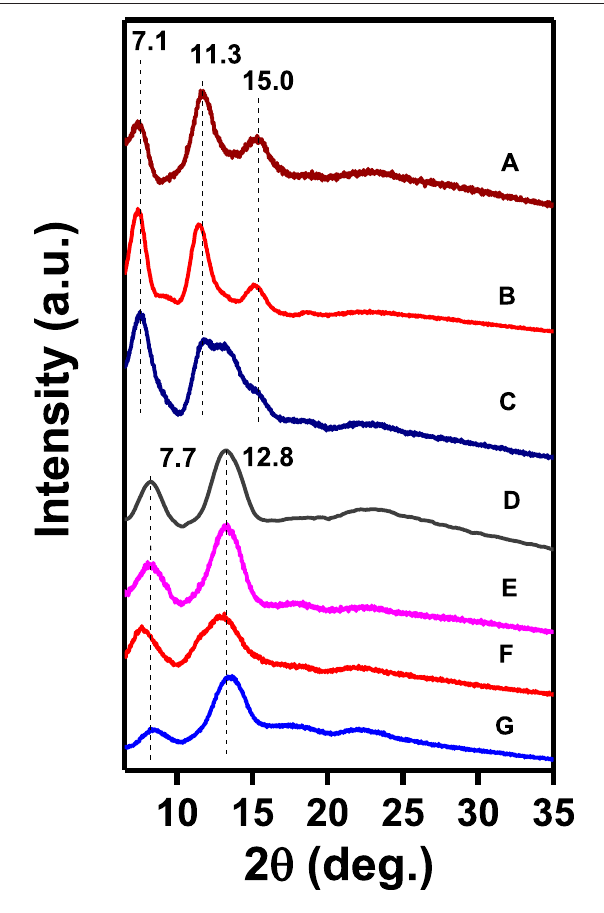
FIGURE 1 | WAXD patterns of NC PPO fi lms as obtained by solution casting, followed by guest extraction by acetonitrile: A) p -xylene, B) 1,3- dichlorobenzene, C) m -xylene, D) perchloroethylene, E) ethylbenzene, F) 1,2- dichloropropane, and G) 1,4-dioxane.